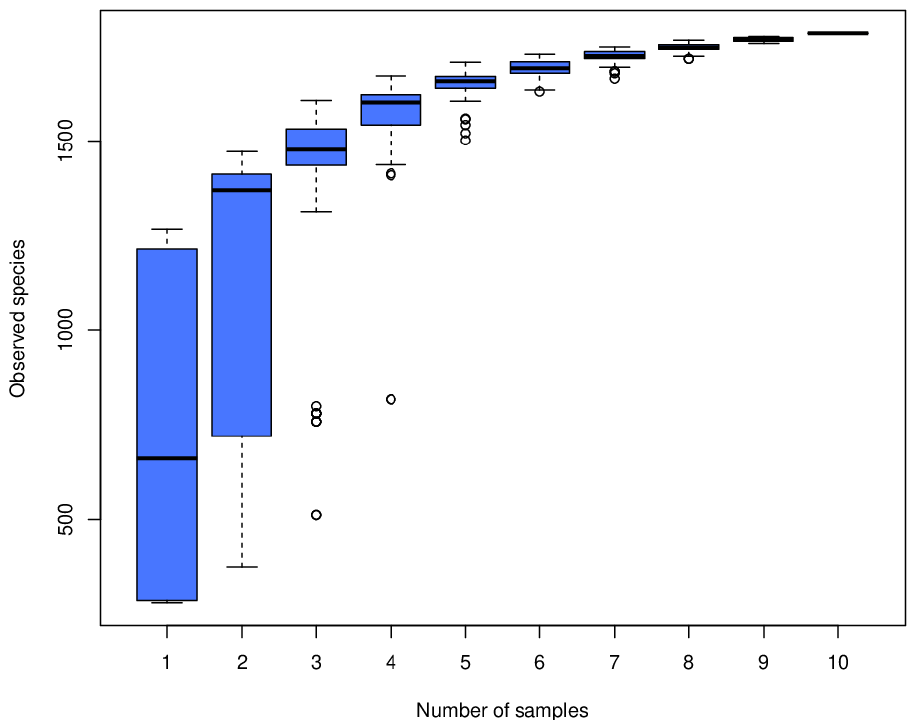
Figure 1. Horizontal axis is the sample size; vertical axis is the number of OTUs after sampling.